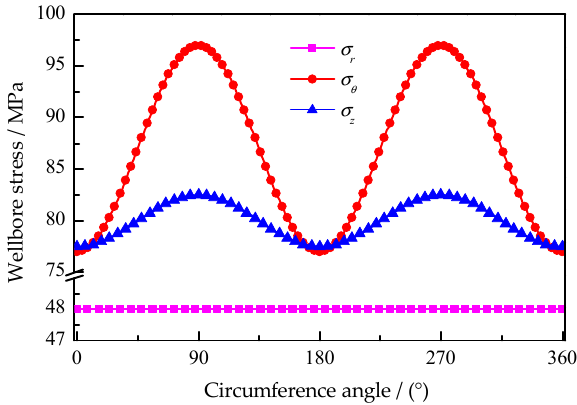
Figure 3. The stress distribution on the borehole wall.